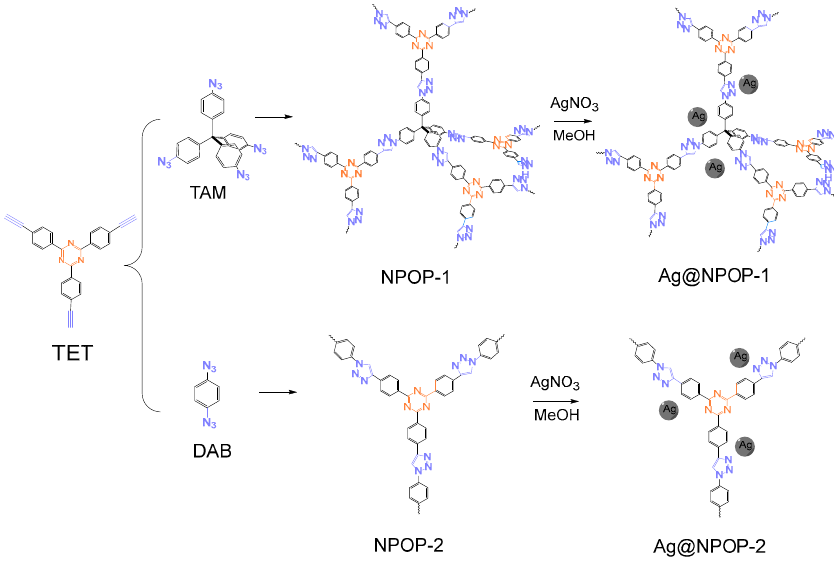
Scheme 1. Illustrated synthetic procedures of NPOPs and Ag@NPOPs.